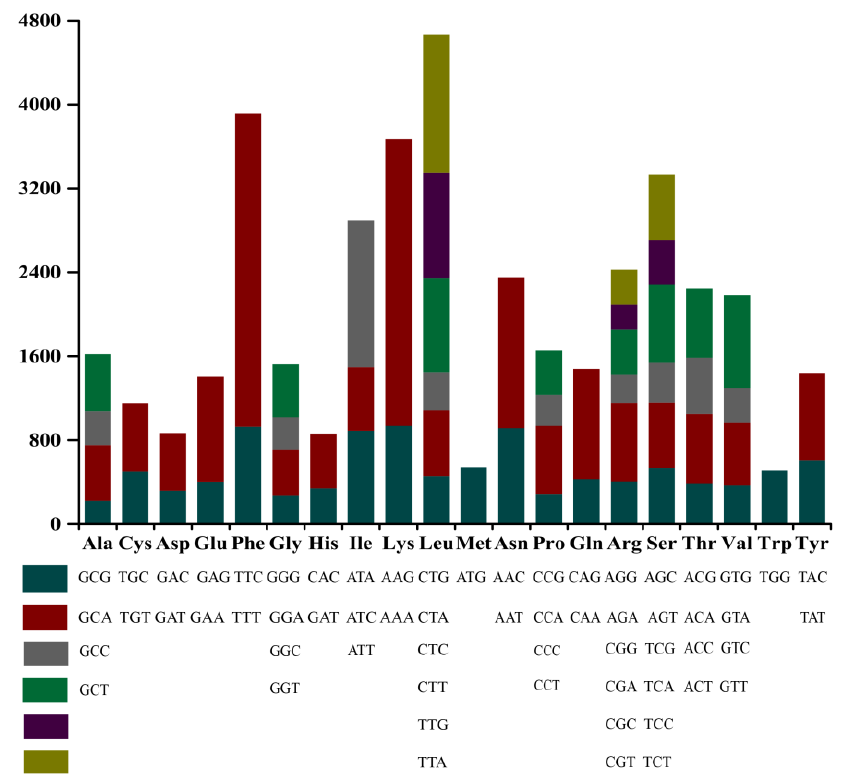
Figure 4. Codon usage in the whole chloroplast genome of Trebouxiophyceae sp. DW1.The x -axis represents amino acids, frequency of codon usage is plotted on the y -axis.